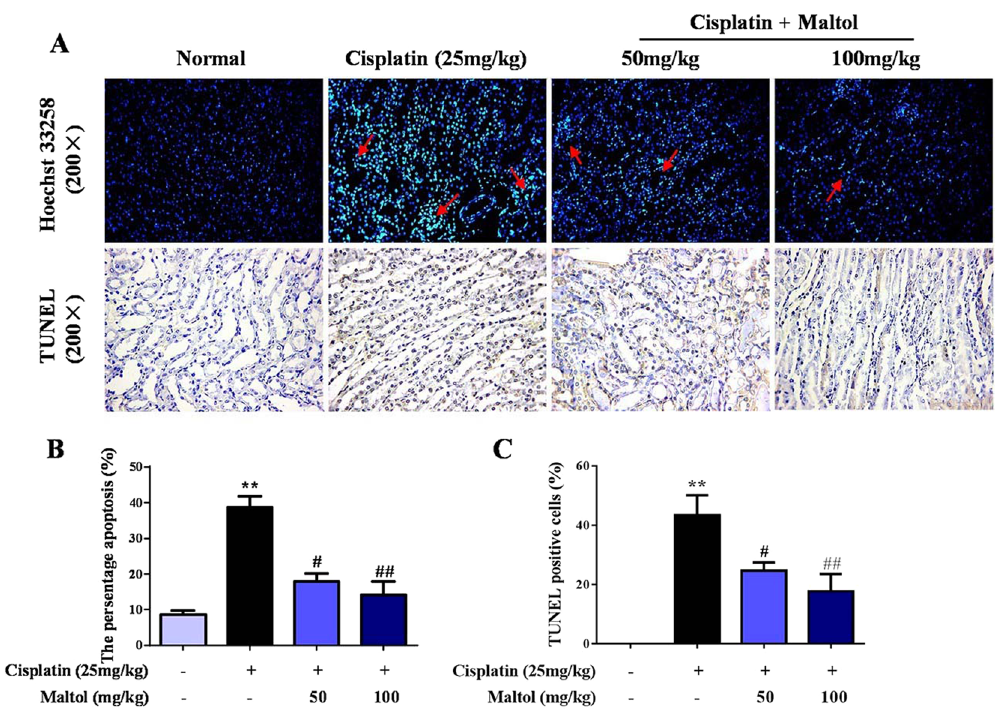
Figure 3. Renal tissues stained with TUNEL staining ( A ) and Hoechst 33258. ( B ) The existence of TUNEL positive cells were assessed by image analyzer. ( C ) The relative levels of fluorescence intensity were quantified. Magnification × 200. Values are expressed as mean ± S.D. ** p < 0.01 vs . normal group; # p < 0.05, ## p < 0.01 vs . cisplatin